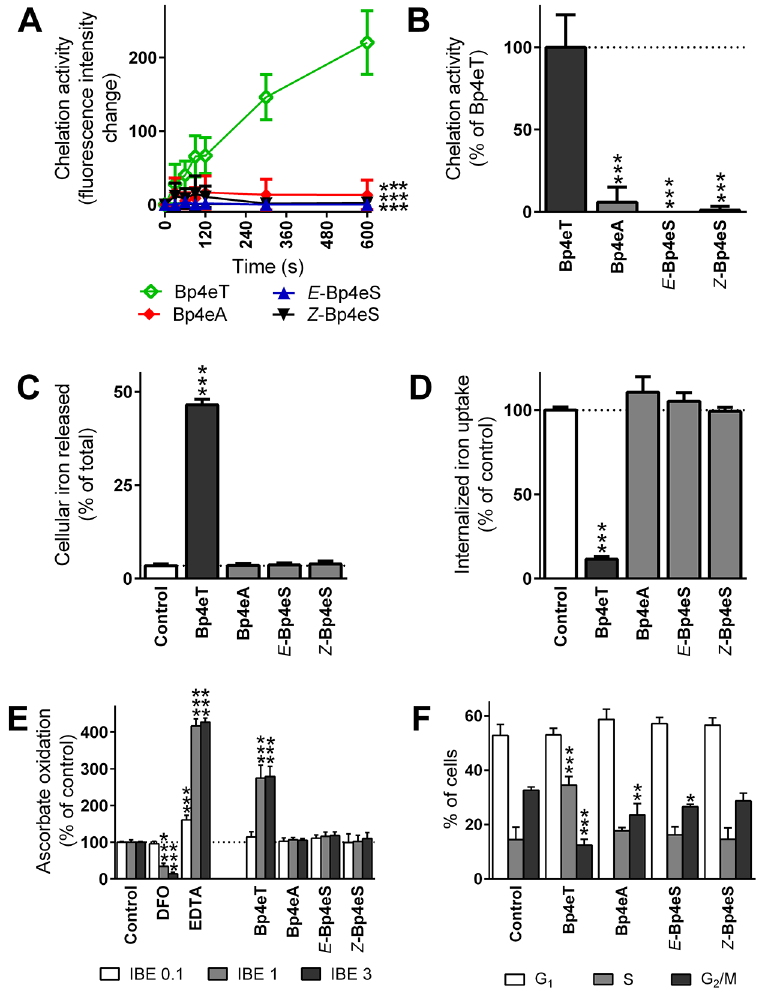
Fig 3. The ability of Bp4eA and Bp4eS to bind iron, to form redox active iron complexes and to cause an increase in the S phase and a decrease of G 2 /M phase of cell cycle was negligible compared to the parent chelator, Bp4eT. The efficacy of Bp4eT or its metabolites to chelate iron from the LIP of MCF-7 cells was measured using the calcein-AM assay. (A) Fluorescence of free calcein after the addition of 10 μ M Bp4eT or its metabolites for 10 min/37°C. (B) Intensity of fluorescence of free calcein in the presence of the metabolites at t = 600 s was expressed as a percentage of the fluorescence of free calcein in the presence of Bp4eT. The results of (A) and (B) are mean ± SD ( n = 6 experiments). Statistical significance (ANOVA): *** p < 0.001 as compared to Bp4eT. (C) Efflux of 59 Fe mediated by control medium or medium containing the agents (25 μ M) after a 3 h/37°C incubation of MCF-7 cells prelabeled with 59 Fe-transferrin. (D) Uptake of 59 Fe from 59 Fe 2 -transferrin by MCF-7 cells in the presence of control medium or medium containing the agents (25 μ M) were determined after a 3 h/37°C incubation. The results of (C) and (D) are mean ± SD ( n (cid:1) 3 experiments). Statistical significance (ANOVA): *** p < 0.001 as compared to the control (untreated) group. (E) The ascorbate oxidation assay was used to examine the formation of redox active complexes. Bp4eT and its metabolites were assayed at iron binding equivalents (IBE) of 0.1 (excess of iron to chelator); 1 (fully complete coordination shell); and 3 (excess of chelator to iron). The chelators, DFO and EDTA, were used as anti-oxidative or pro-oxidative controls, respectively. Data are expressed as a percentage of the control group without chelator at the same IBE (100%). The results of (E) are mean ± SD ( n (cid:1) 3) experiments. Statistical significance (ANOVA): *** p < 0.001 as compared to the control group (iron with ascorbate) in the same IBE. (F) MCF-7 cells were incubated for 72 h/37°C with 100 nM of Bp4eT or its metabolites, Bp4eA and Bp4eS. Cell cycle analysis was processed by flow cytometry using propidium iodide. Phase quantification was evaluated using MultiCycle AV Software. The results of (F) are mean ± SD ( n (cid:1) 3 experiments). Statistical significance (ANOVA): * p < 0.05, ** p < 0.01, *** p < 0.001 as compared to the control